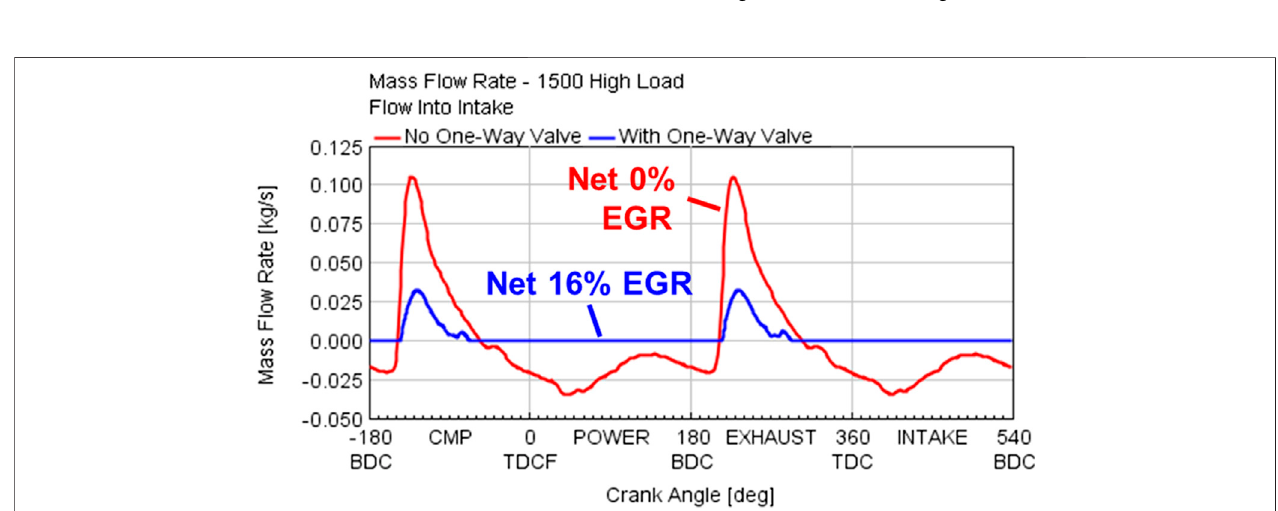
FIGURE 13 | EGR fl ow with the one-way valve at low-speed and high load